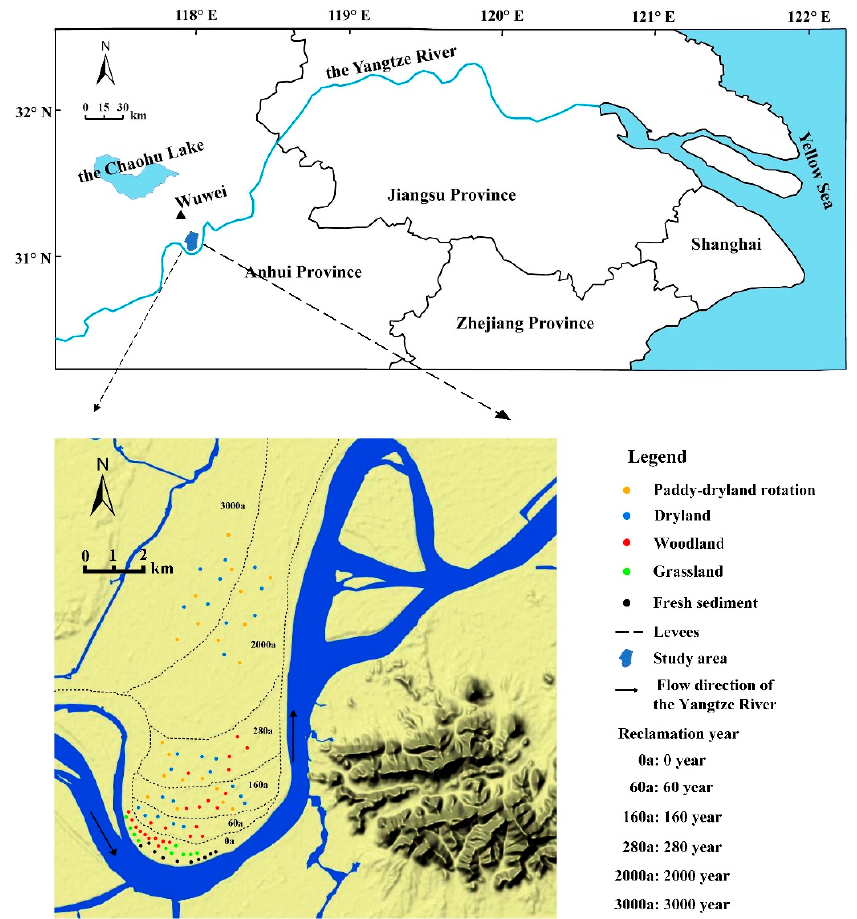
Figure 1. Geographic location of the study area and sampling sites.